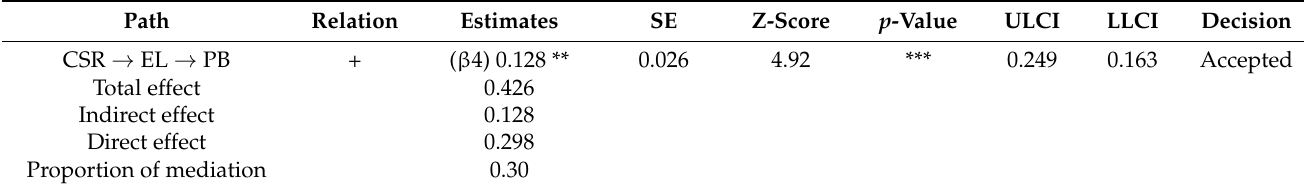
Table 6. Mediation results for